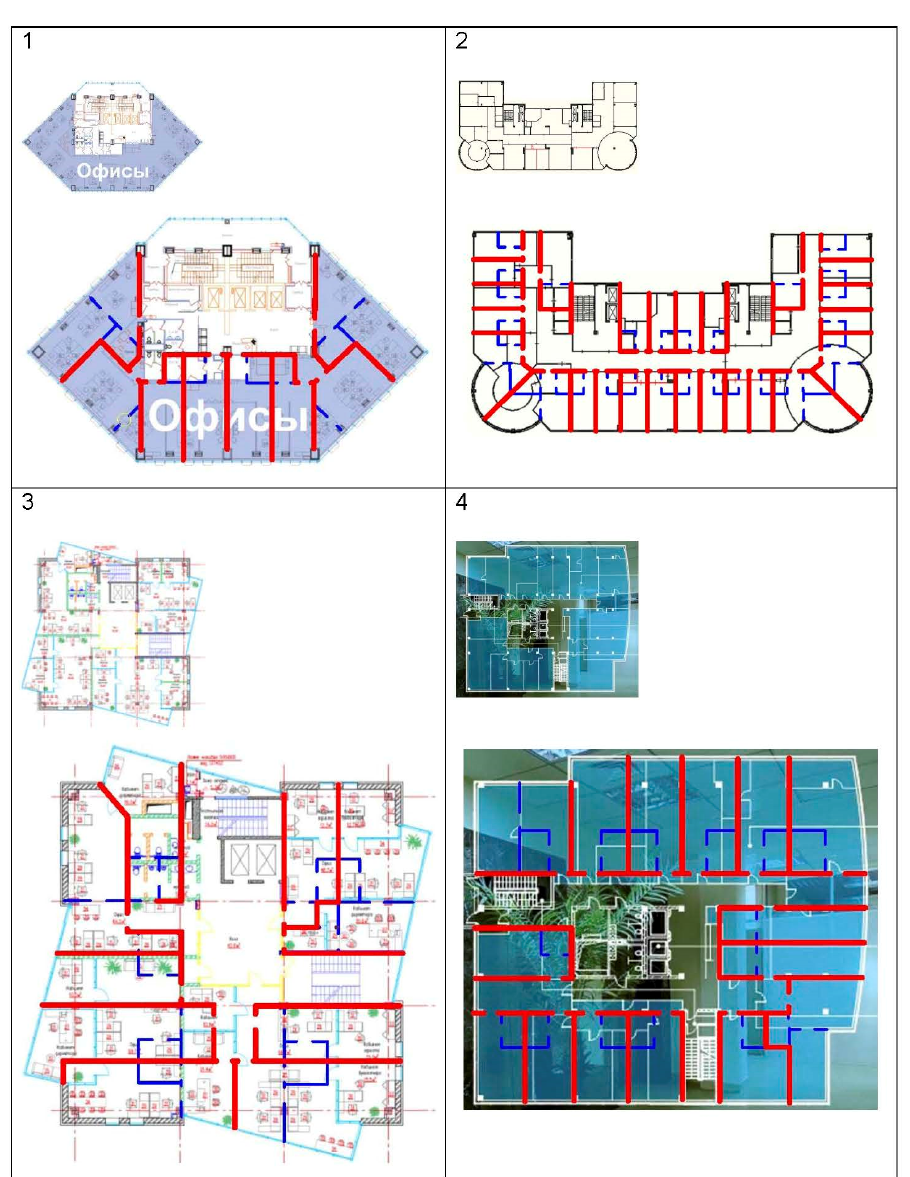
Figure 29. Business center redevelopment options—hotels (authors’ drawings based on existing layouts [97,125,159,160]): ( 1 ) the Almaty Towers, Almaty; ( 2 ) the Nursaulet, Astana; ( 3 ) the Seven, Astana; and ( 4 ) the City Kostanay, Kostanay.